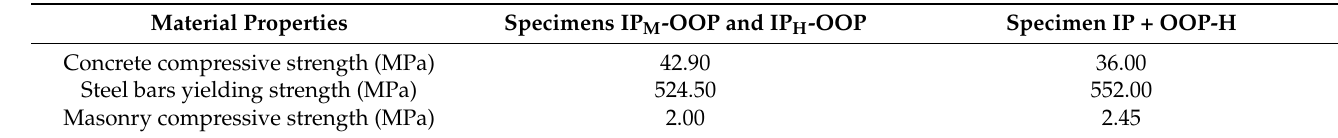
Table 5. Mechanical properties of the material of test specimens.